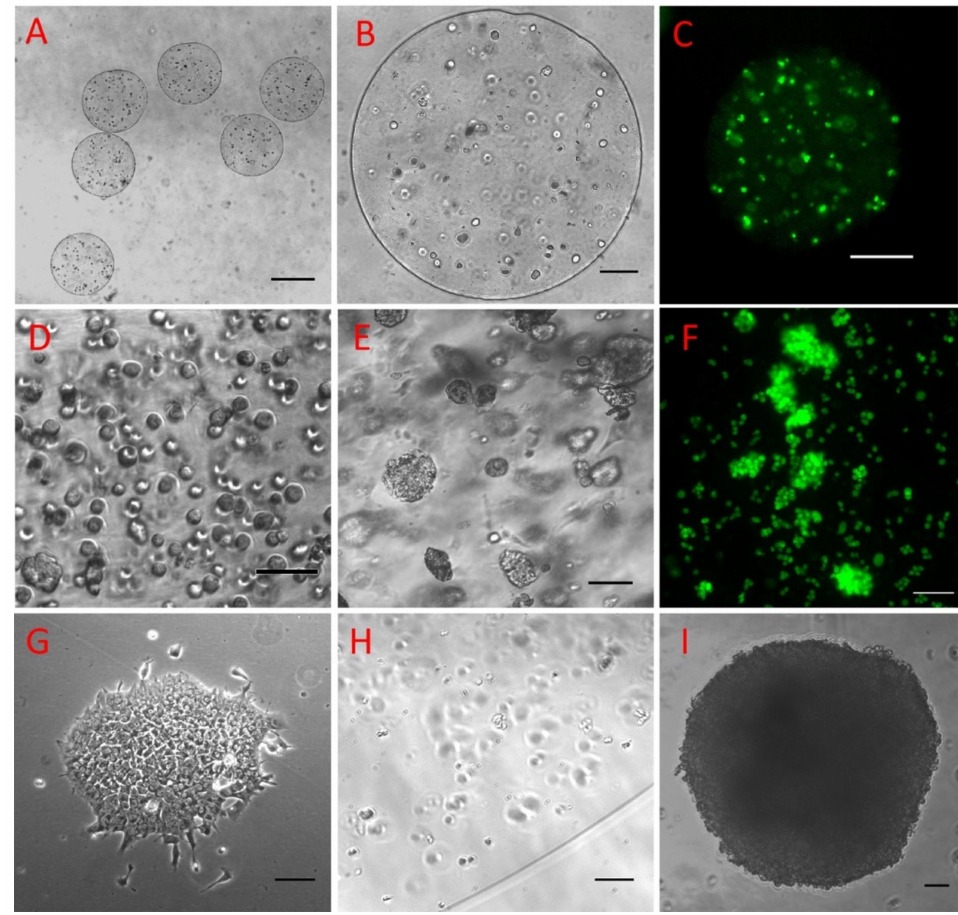
Figure 4. Typical views of 143B human osteosarcoma cells at a cell concentration of 1 × 10 6 / mL immediately after the alginate hydrogel has solidified ( A – C ). The uniformity of the cell-incorporated alginate microbeads ( A ) and the cell distribution within a microbead ( B ) are shown. Cells were highly viable as demonstrated by the Calcein AM staining ( C ). The 143B cells were bioprinted at a concentration of 6 × 10 6 / mL and were evenly distributed immediately after bioprinting ( D ). The 143B cells grew into nodules after 7 days of culture ( E ), and the nodules and cancer cells were highly viable cells after isolation from the microtissue ( F ). IPS cells grew into a clone in 2D culture ( G ) and they were evenly distributed at low concentration inside the alginate microbeads immediately after bioprinting ( H ) and grew into an embryonic body following in vitro culture ( I ). Bars: A: 100 µ m, B: 500 µ m, C: 200 µ m, D,E: 200 µ m, F–I: 100 µ